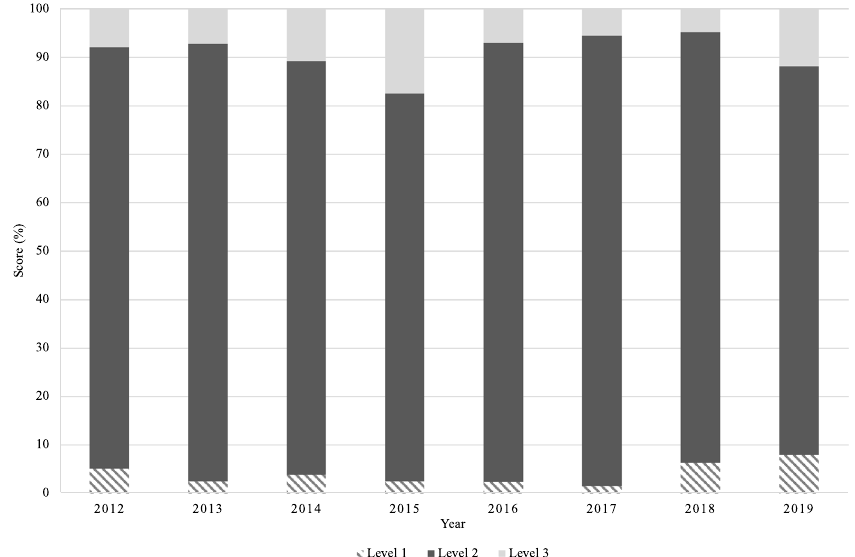
Fig. 2 Score distribution by cognitive level by year. *Level 4 items are not applicable to standardized tests such as the